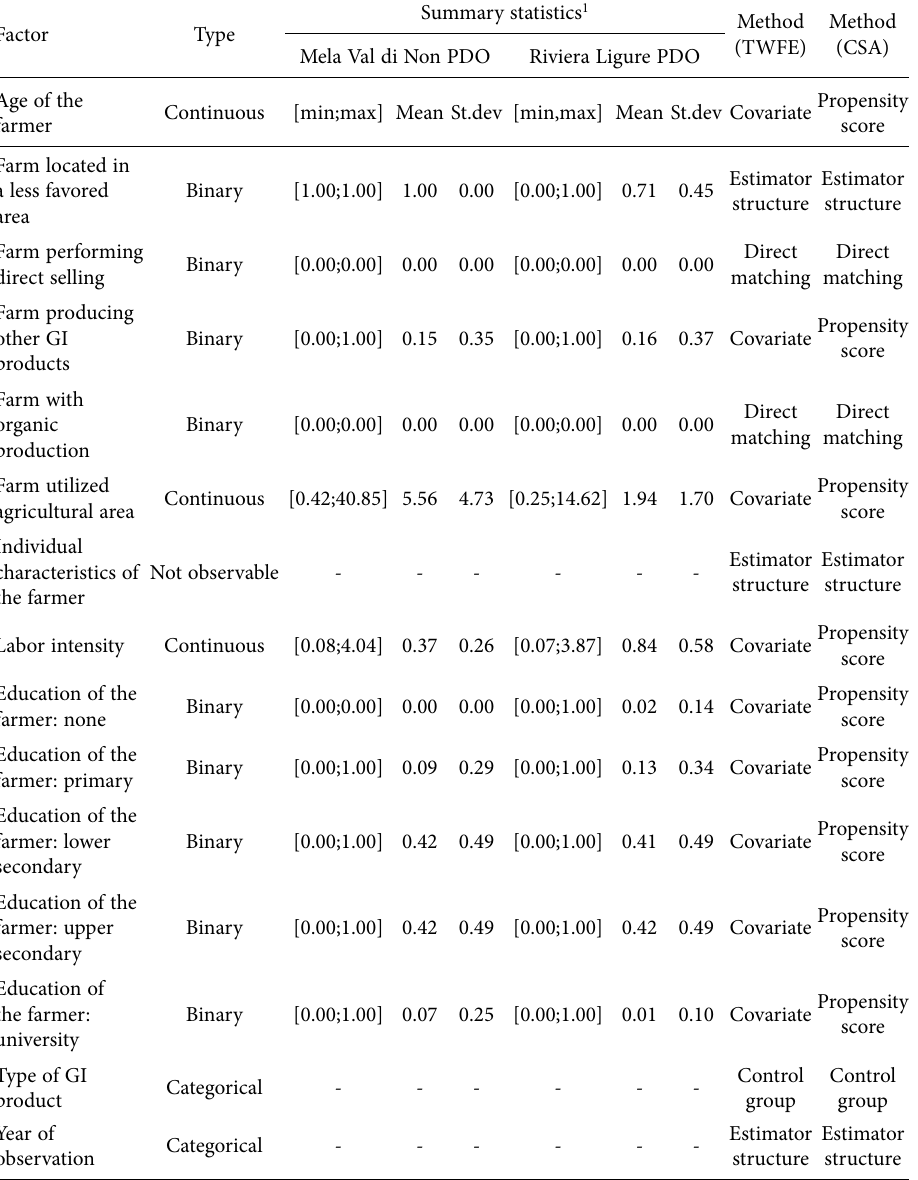
Table 2. Factors to be controlled for in the